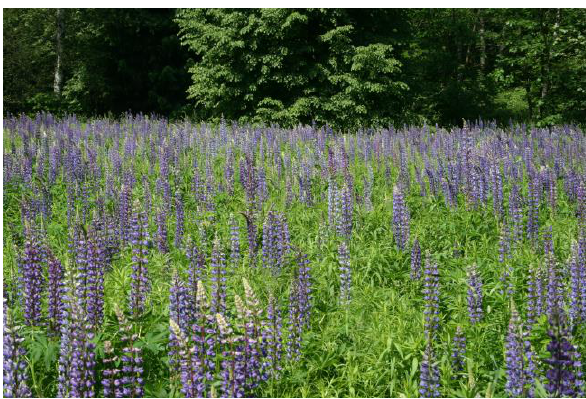
Fig. 7. Monodominant communities of Lupinus polyphyllus Lindl. at the forest edge in the Vitebsk Oblast of